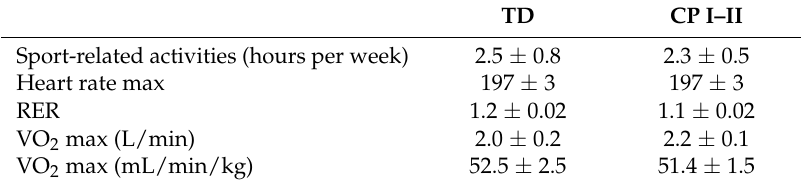
Table 2. Physical fitness capacity determined as maximal oxygen uptake (VO 2 max).